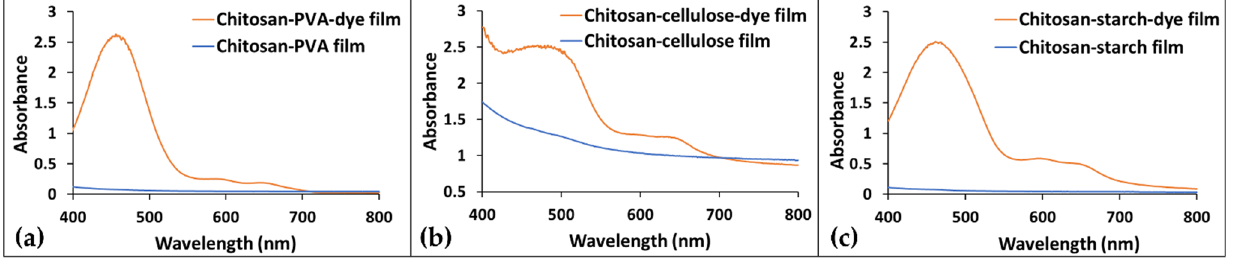
Figure 5. UV-VIS spectra of the bio-based polymeric films (control and with dye): ( a ) chitosan- PVA, ( b ) chitosan-cellulose and ( c )